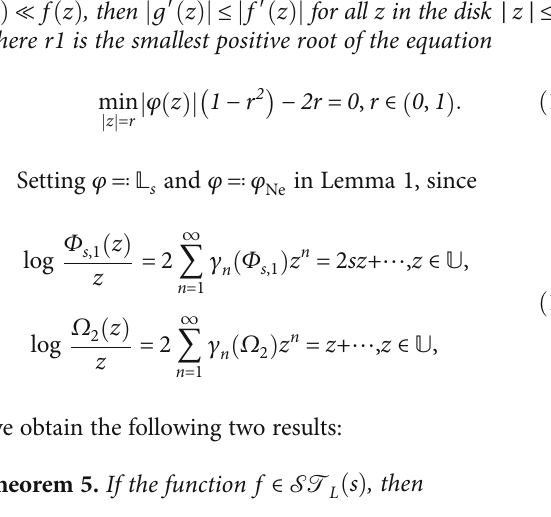
Figure 1: The plot of G ð s Þ for s ∈ ð 0, 1/